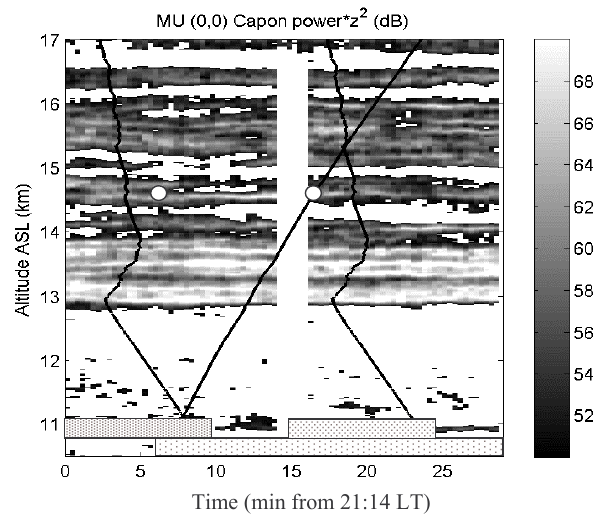
Fig. 8. Close-up of the height-time intensity plot of echo power (compensated from the range attenuation effects) after the Capon processing for about 30min after the beginning of the experiment. The oblique line indicates the balloon path. The temperature profile (black) adjusted to the plot is plotted twice for comparing with the power map at two different times. The light, moderate and heavy grey rectangles represent the time period used for averaging the power profiles shown in Fig. 4a (6a), Figs. 10a and b, respectively. The white circle on the balloon path line is the position analyzed in Fig. 9 and the second white circle plotted 10min before would correspond to the conditions met by the balloon if the frozen-in ad- vection was taken into